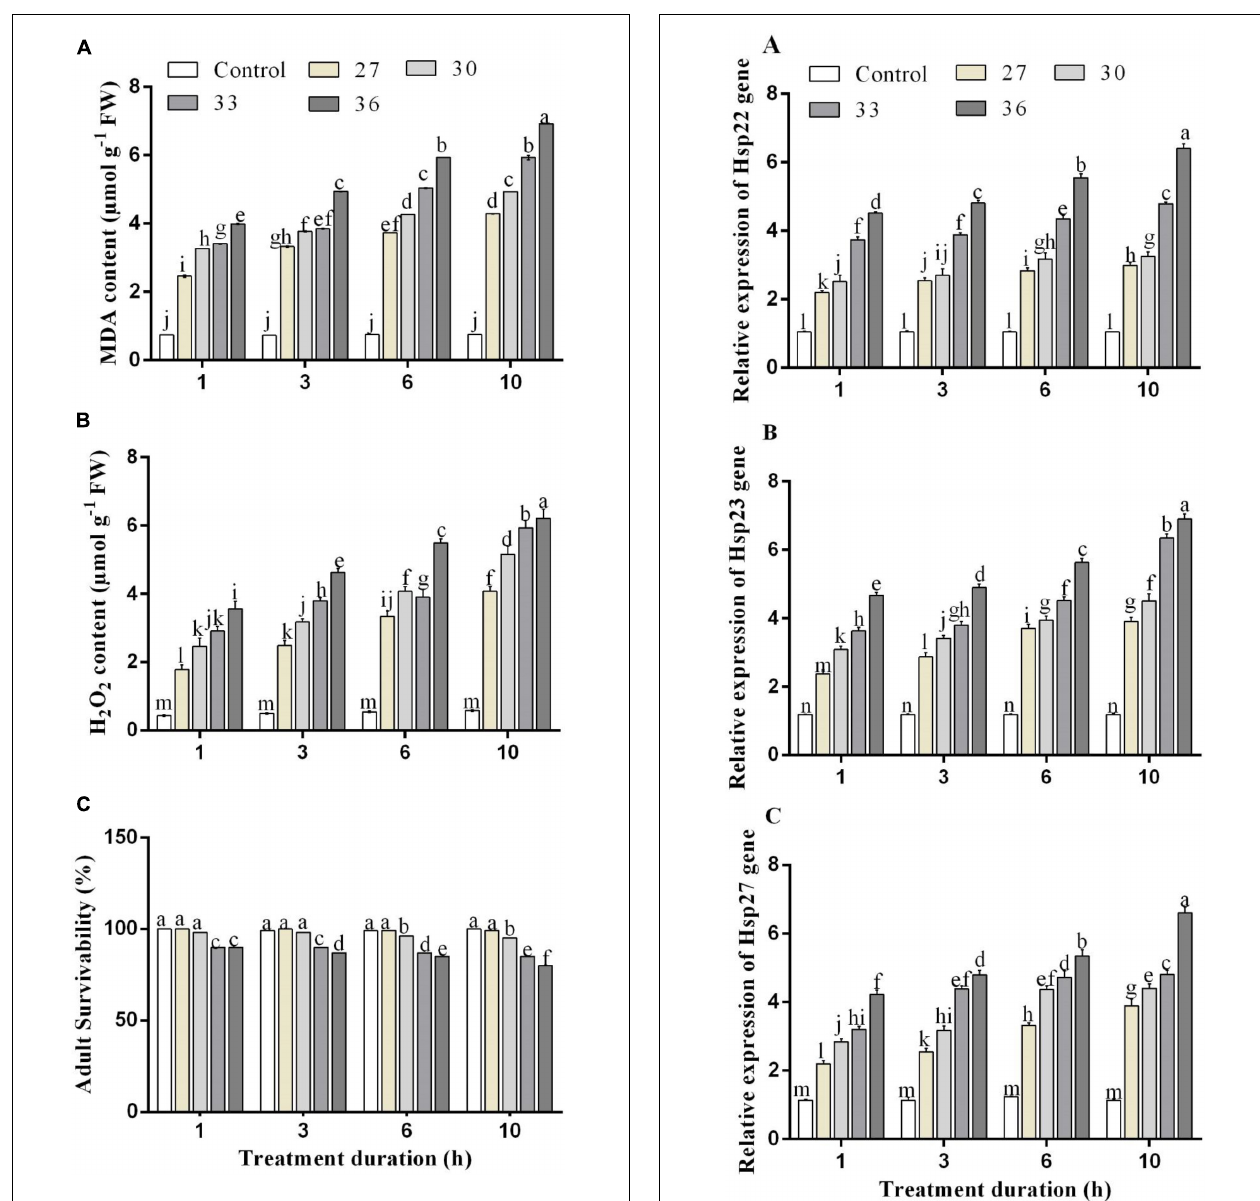
FIGURE 3 | Relative expression of (A) Hsp 22, (B) Hsp 23, and (C) Hsp 27 genes in M. persicae under different heat stresses (27, 30, 33, and 36 ◦ C) at different durations (1, 3, 6, and 10 h) in growth chambers. Small bars represent the standard errors of the means. Different lower case letters indicate significant differences between treatments at Tukey’s HSD test ( p < 0.05) using one-way